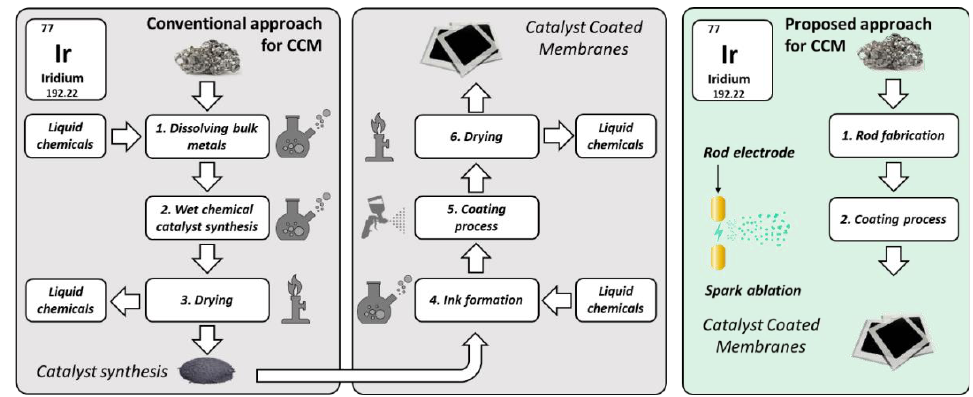
Figure 5. Schematic illustration of the fabrication process of CCMs using the conventional approach and the approach that is proposed here, based on spark ablation. and the approach that is proposed here, based on spark